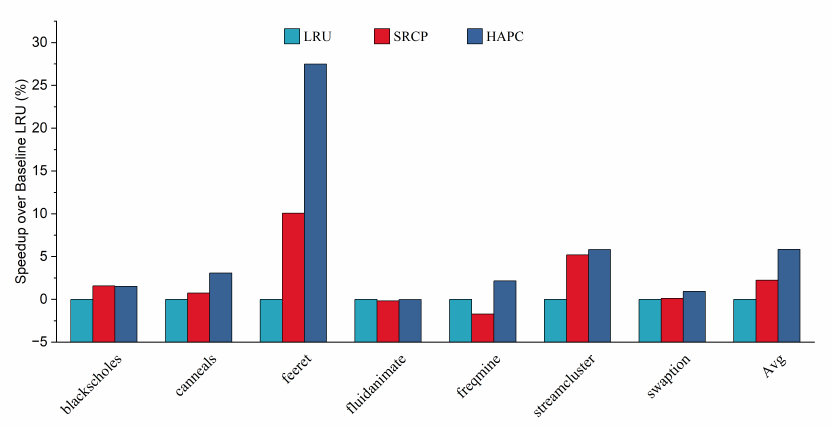
Figure 9. Speedup over baseline